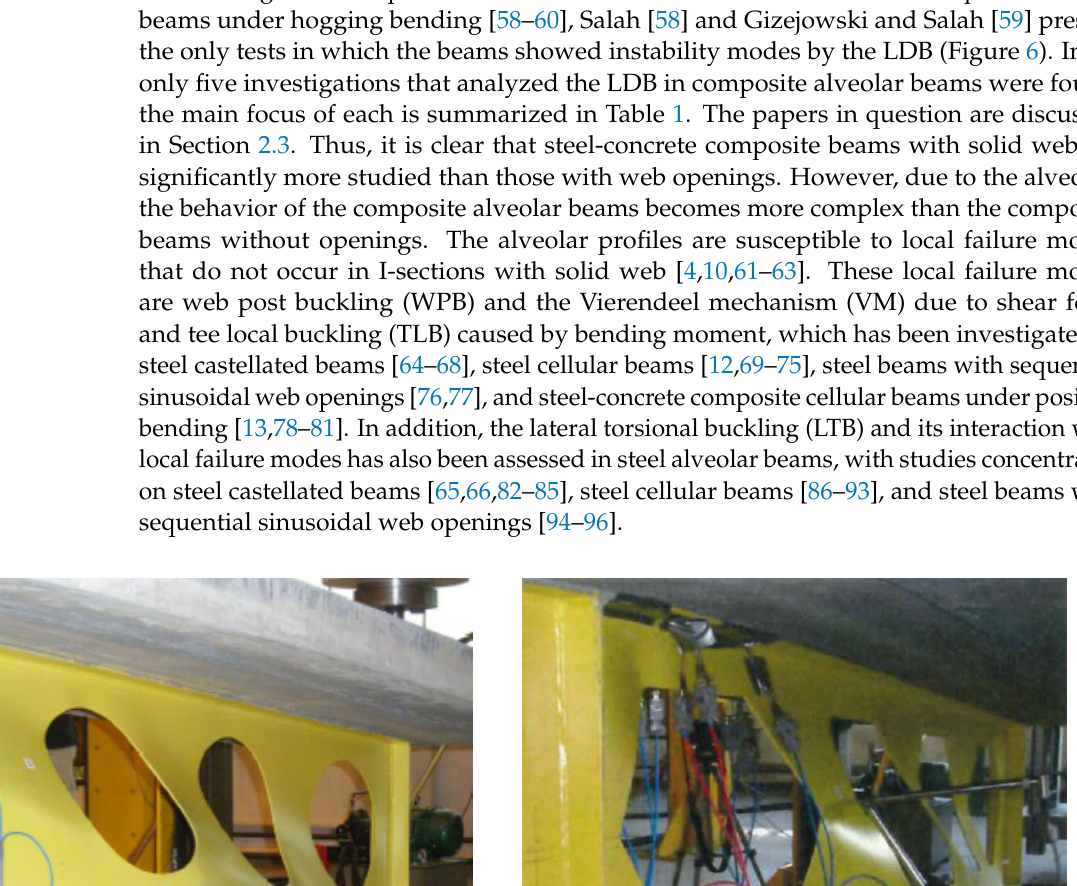
Figure 5. Lateral distortional buckling in steel-concrete composite beams: ( a ) Cross-section behavior (Adapted from Rossi et al. [16]); ( b ) Experimental tests by Kitaoka et al. [35].